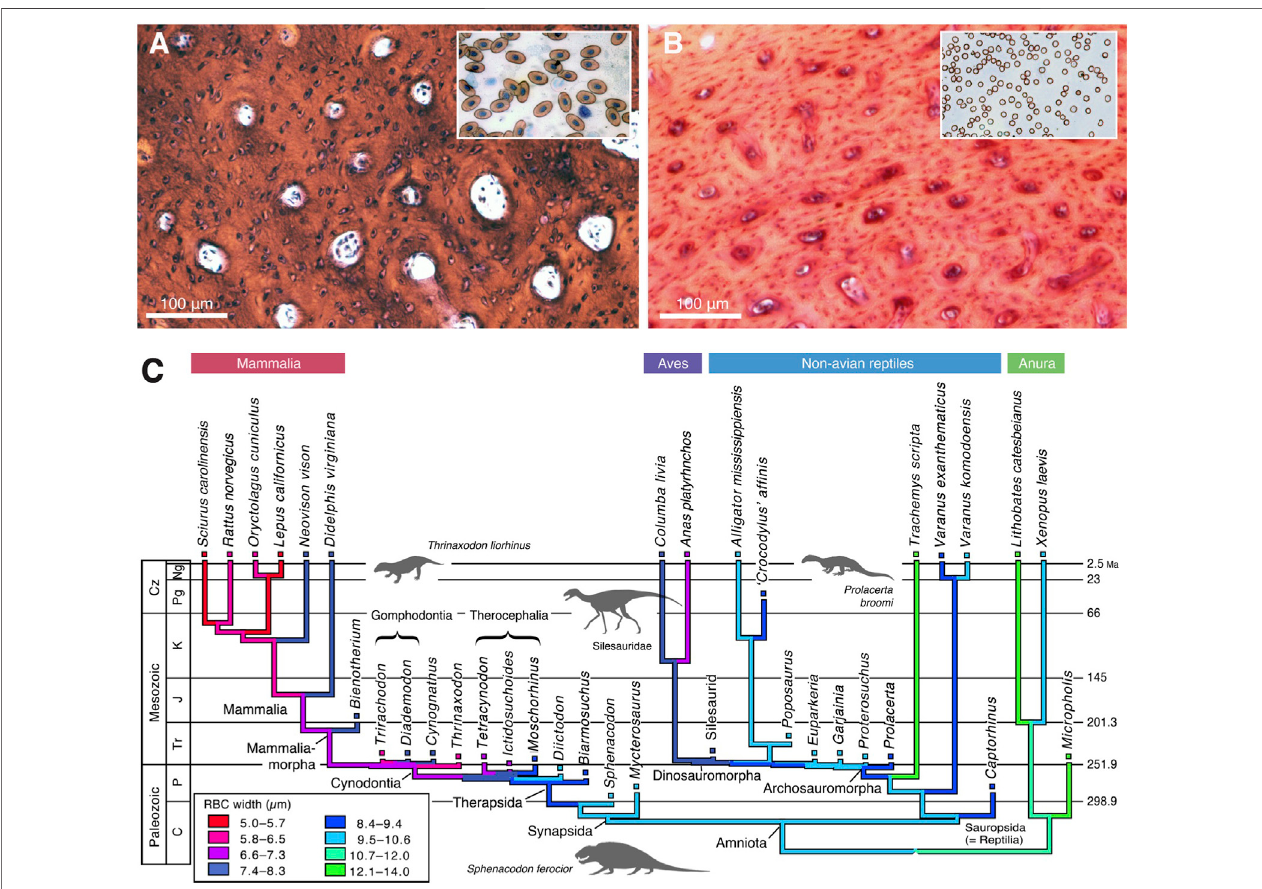
FIGURE 6 | Bone microvascularization and red blood diameter. (A,B) Microphotographs of histological sections of limb bones of American bullfrog (A) and rabbit (VB), with diagrammatic version to show larger vessels and fewer of them in the ectotherm (A) than in the endotherm (B) . (C) Phylogenetic tree showing optimisation of ancestral states reconstruction of red blood cell size (based on bone microvascularization) for tetrapods; among synapsids, therocephalians and cynodonts show mammal-like red blood cell sizes by the Permian-Triassic transition, whereas Triassic archosaurs show a mix of modern bird and crocodilian values in the Triassic. All images courtesy of Adam